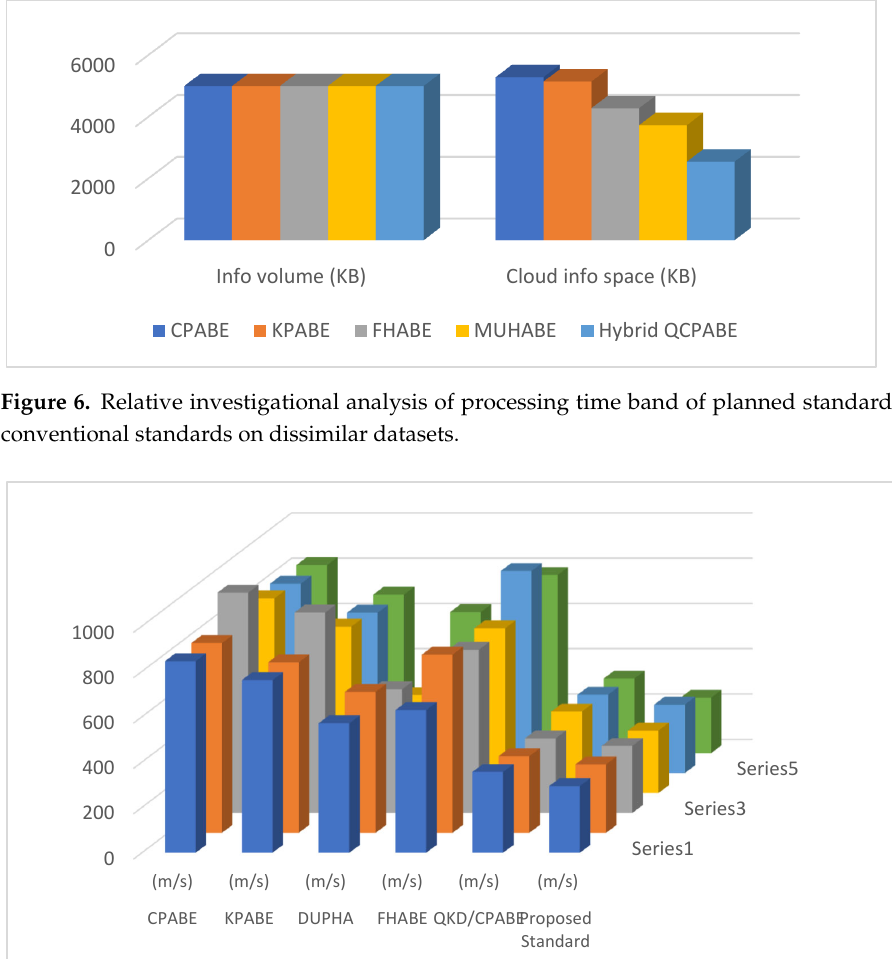
Figure 8, exemplifies the comparative analysis of the Hybrid QCPABE over the con ‐